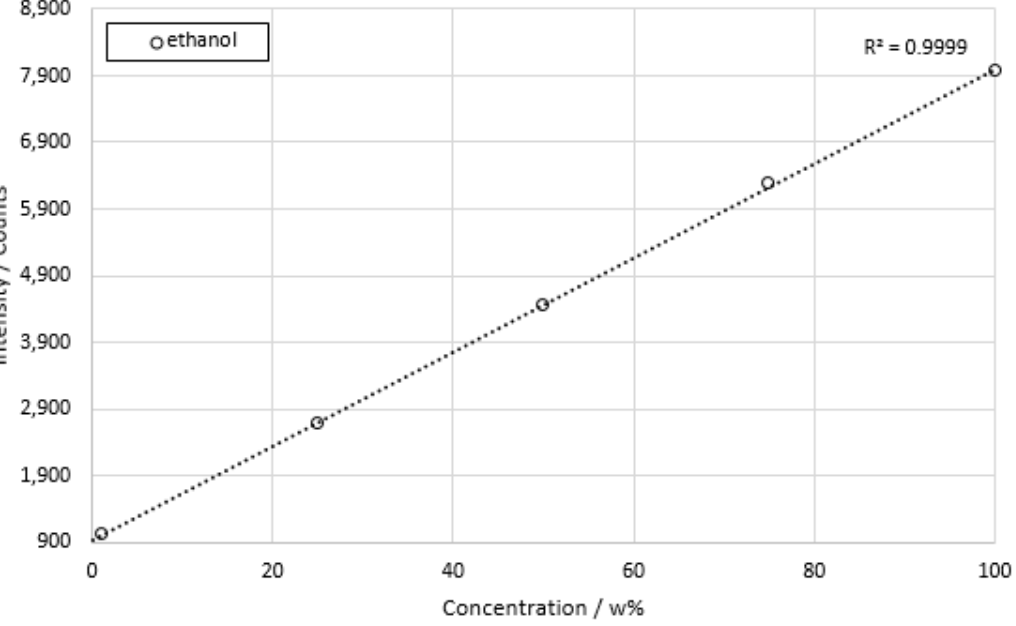
Figure 13. Concentration series of ethanol in deionized water. Integration time 100 ms. Total measuring time per concentration approx. 2 min.